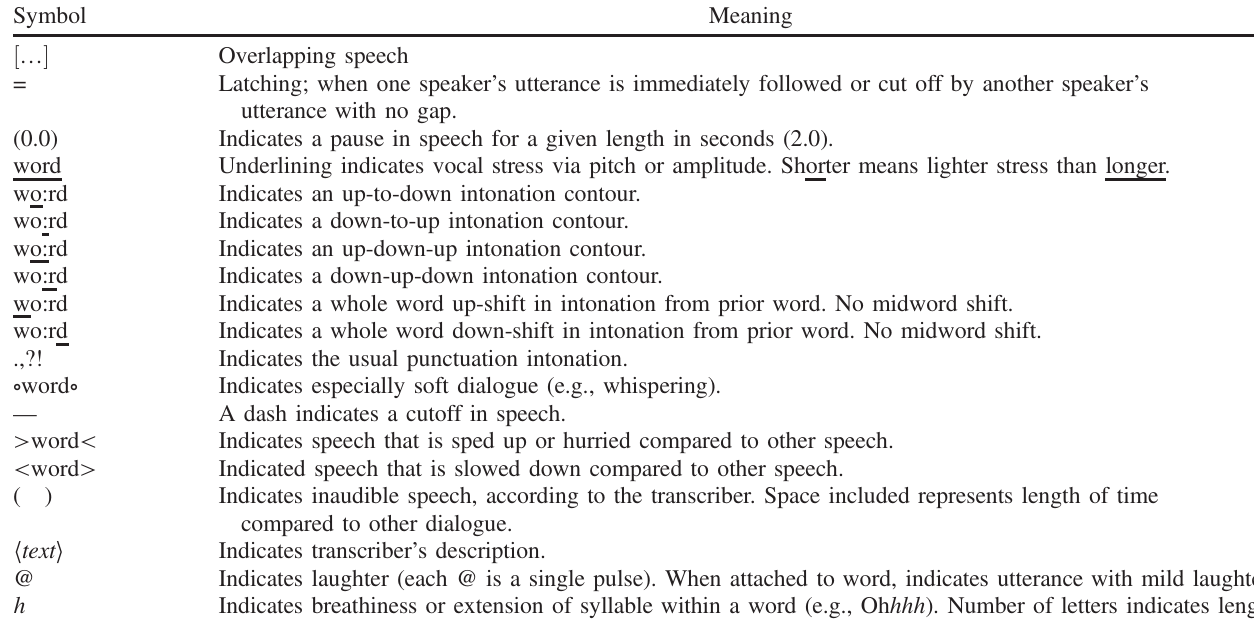
TABLE I. Transcription conventions.